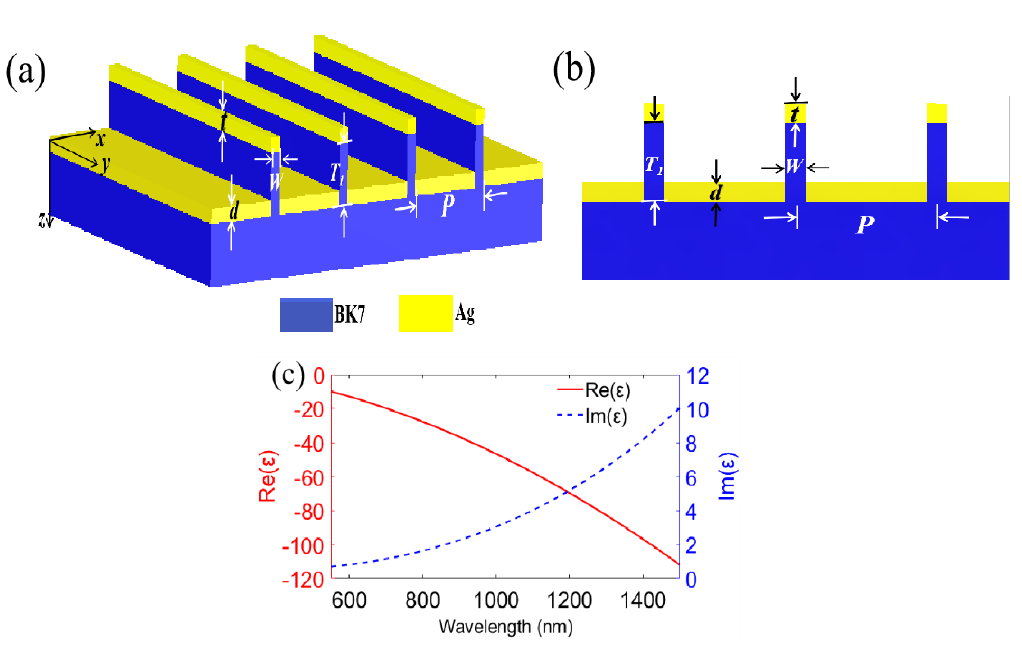
Figure 1. Nanograting-coated single layer metal film and material parameters. ( a ) Three-dimensional schematic diagram; ( b ) Cross-section of designed grating; ( c ) The relative permittivity of silver.